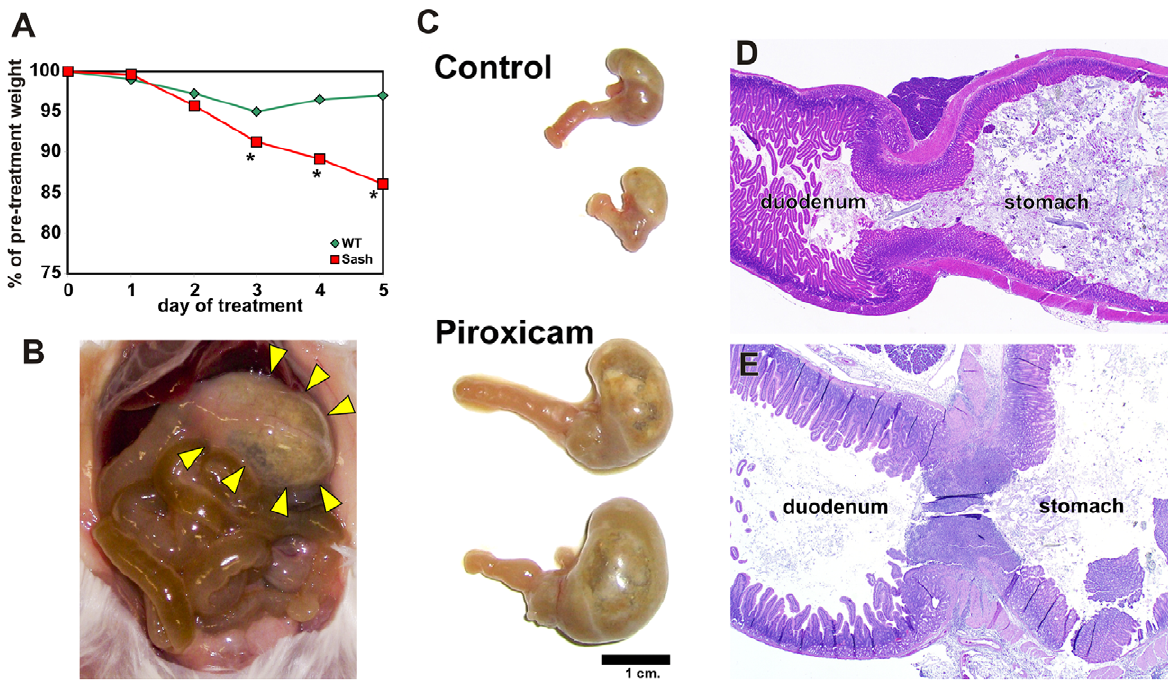
Figure 1. Mast cell-deficient Sash mice are highly susceptible to NSAID-induced peptic ulcers. A. Mean weight data is shown for 13 Sash and 10 wild type (WT) mice exposed to 200 ppm piroxicam in their diet. SEMs ranged from 0.4–1.6% of pre-treatment weight; error bars were omitted for clarity. The rapid weight loss correlates with decreased intake of food and water. Euthanasia for humane reasons was typically required on days 4–6. * indicates p # 0.05 relative to WT mice. Piroxicam-exposed Sash mice demonstrated marked gastric distension by gas and fluid (B, bottom half of panel C) compared with Sash mice not exposed to piroxicam (labeled ‘‘control’’ in panel C). Histologic examination showed ulceration at the gastroduodenal junction (E) of Sash mice, with marked inflammatory cell infiltration and edema that led to gastric outlet obstruction. WT mice (D) do not typically develop ulcers or changes in stomach size with piroxicam exposure.